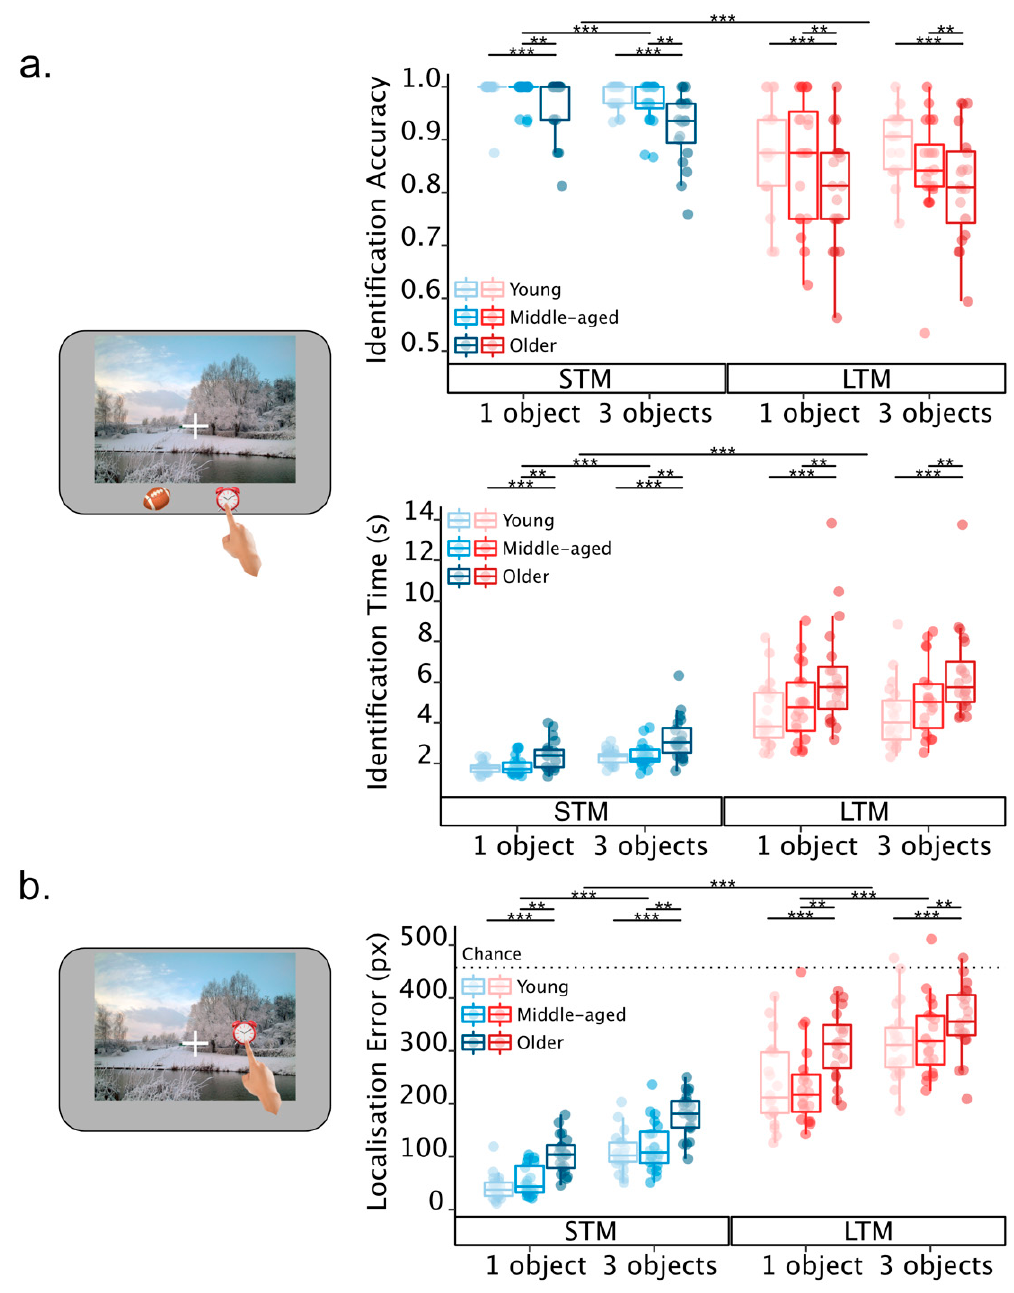
Figure 2. ( a ) Identification performance and ( b ) Localisation error in Experiment 1. Overall, older adults performed worse than both young and middle-aged individuals, whose performance was comparable across the tasks and for both identification and localisation. Coloured dots represent participant means, lines inside boxes represent group medians, hinges represent first and third quartiles, and whiskers represent values that fall outside the IQR but within 1.5 IQR from each hinge. *** denotes p < 0.001, ** denotes 0.001 < p <